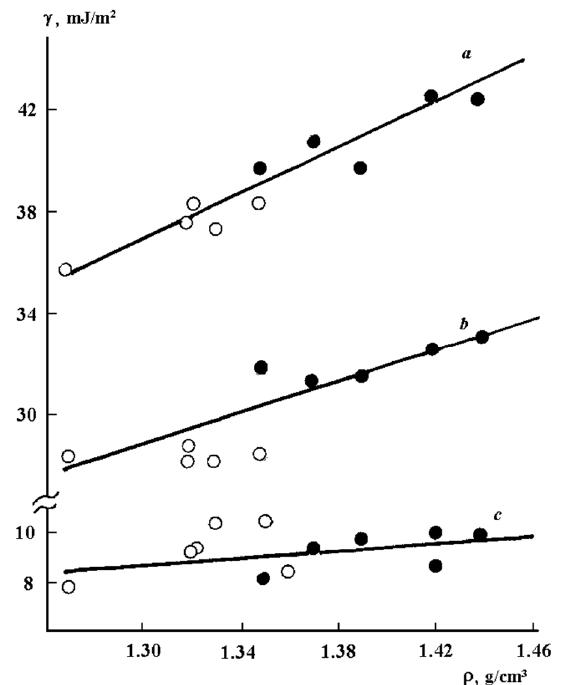
Figure 4. Dependence of ( a ) surface energy, ( b ) its dispersion, and ( c ) polar components on PAI density. ο — before annealing; • — after annealing at 523 К , 3 h.